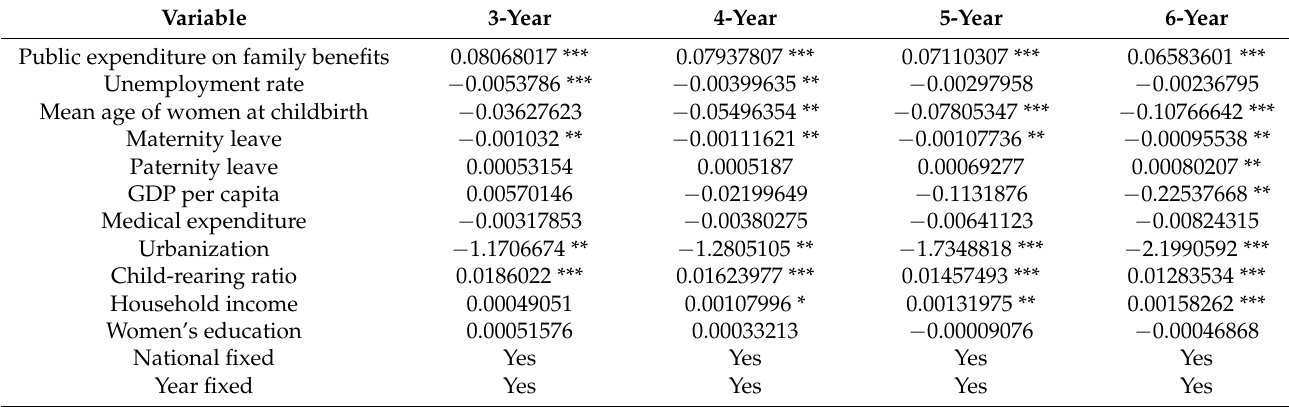
Table 5. Tests of the long-term effects of family welfare policies (moving mean